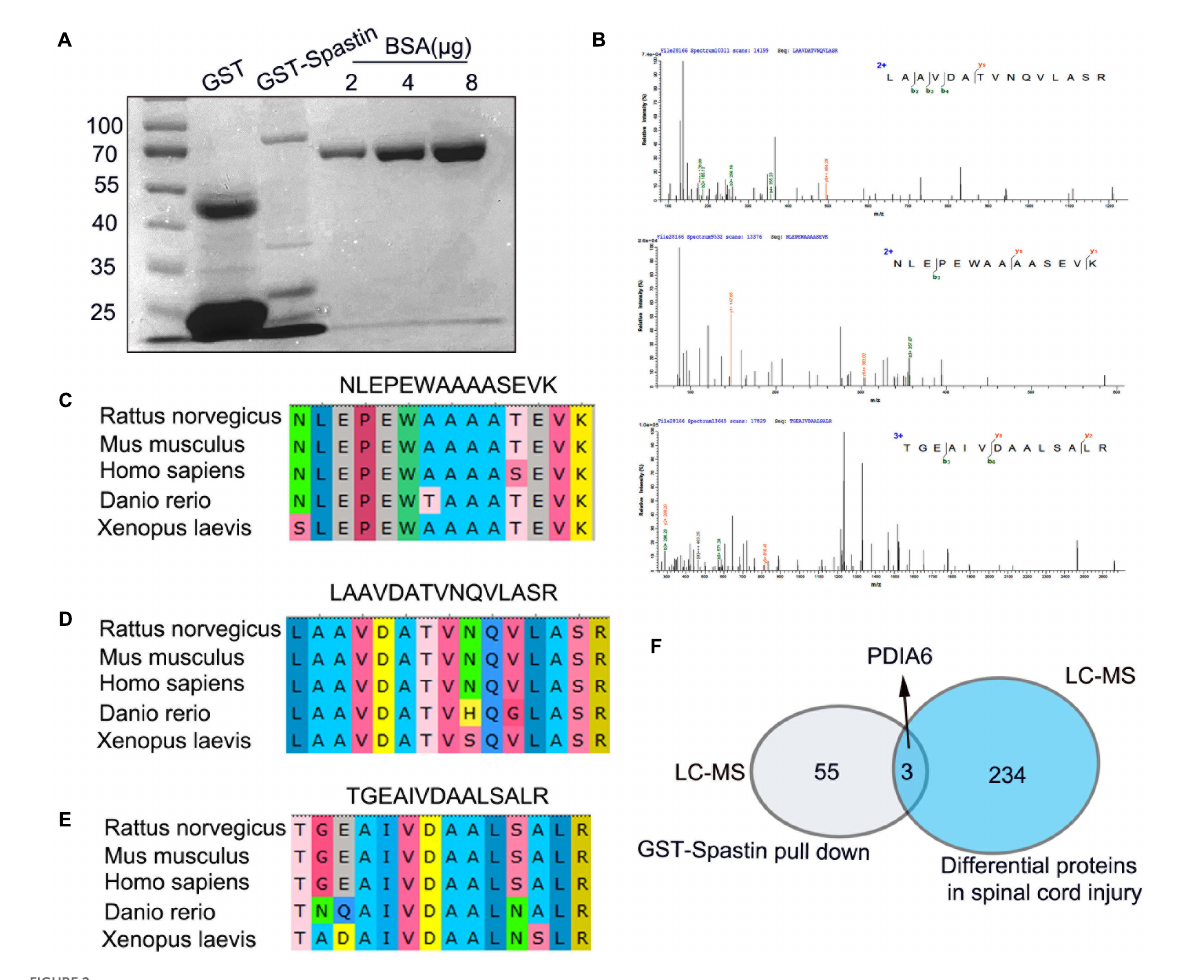
FIGURE2 Peptides derived from PDIA6 interact with spastin. (A) GST and GST-Spastin protein purification, with BSA serving as a loading control. (B) Peptides capable of interacting with GST-spastin were analyzed via LC-MS, leading to the identification of three PDIA6-derived peptides (LAAVDATVNQVLASR, NLEPEWAAAASEVK, and TGEAIVDAALSALR). (C–E) Significant homology was observed among species when assessing the sequences of the three identified PDIA6-derived peptides. (F) PDIA6 is both differentially expressed following SCI and has the potential to interact with